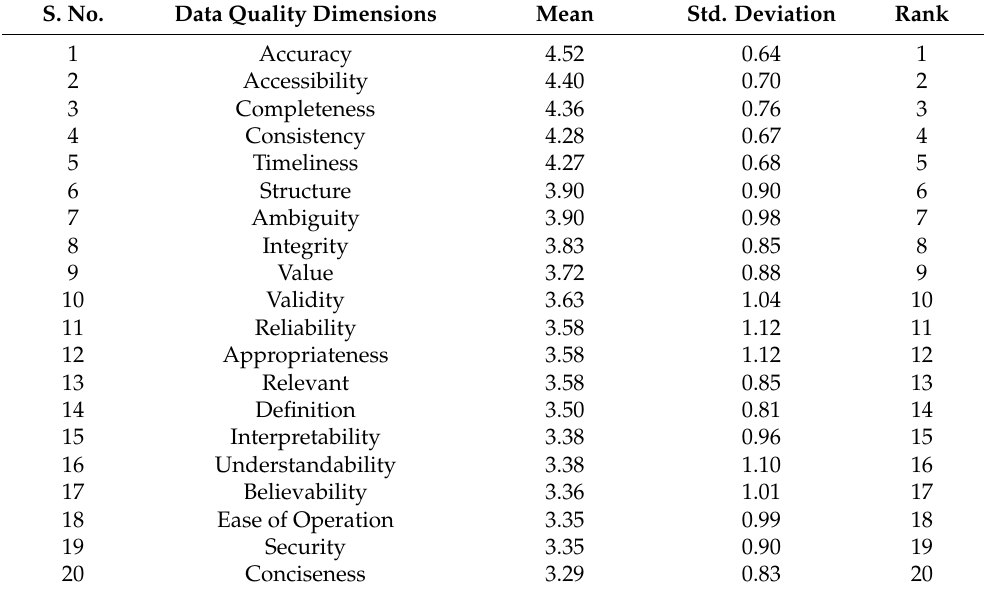
Table 3. Ranking of data quality